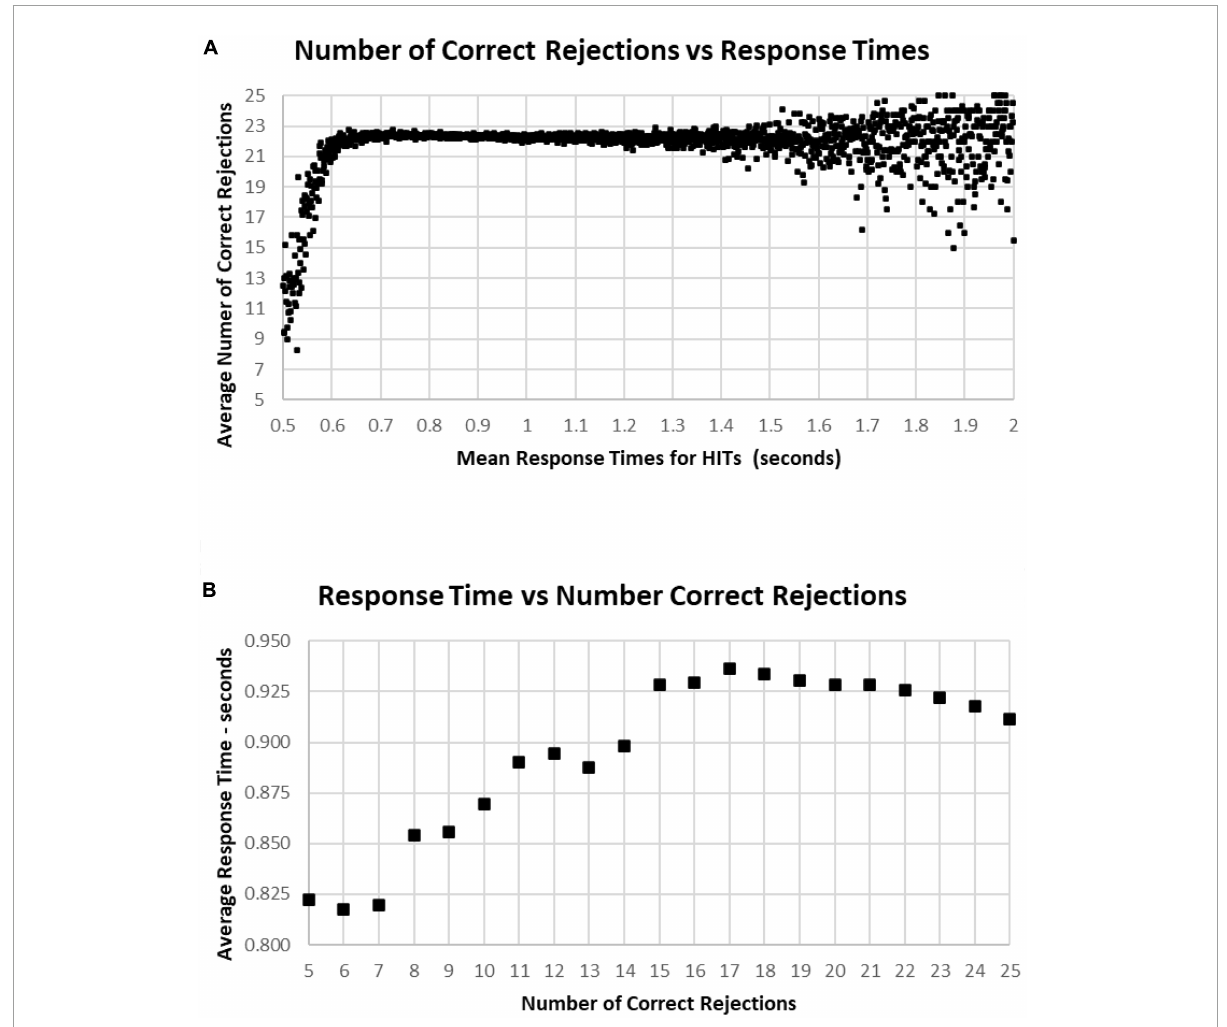
FIGURE12 (A) Average number of Correct Rejections for each RT, showing the Correct Rejection of component of correct responses. Note that that over an RT of 0.650 s, there is essentially no relationship of Correct Rejections and RT, with about 22 Correct Rejections occurring on the average. By contrast, for faster RTs, there is a steep speed/accuracy trade-off between speed and accuracy of Correct Rejections. Again, the small number of tests above 1.4 s show the dispersion with fewer tests, but there is no indication of a different slope. (B) Again, same data as (A) , showing an RT of 0.911 s for 25 Correct Rejections and a slight increase of RT down to 15 Correct Rejection, but there are faster RTs with lower numbers of Correct Rejections, which reflects the alteration of strategy (less inhibition) associated with this aspect of poor performance on the MemTrax